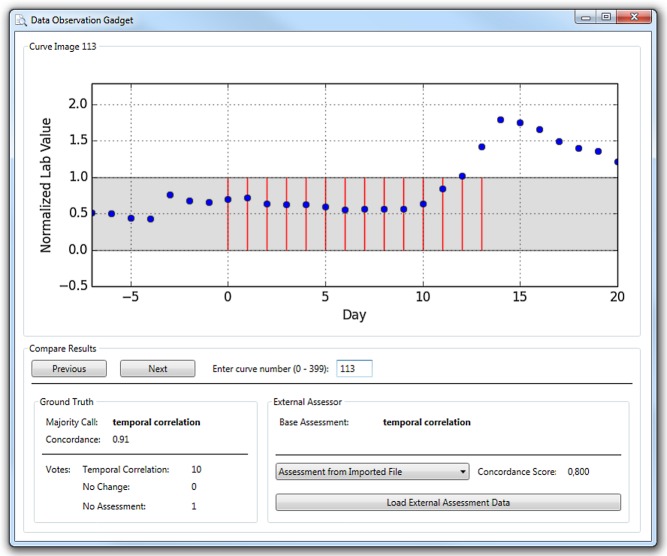
Screenshot of the reutilization tool that allows for comparing other assessment results with the ground truth classification.